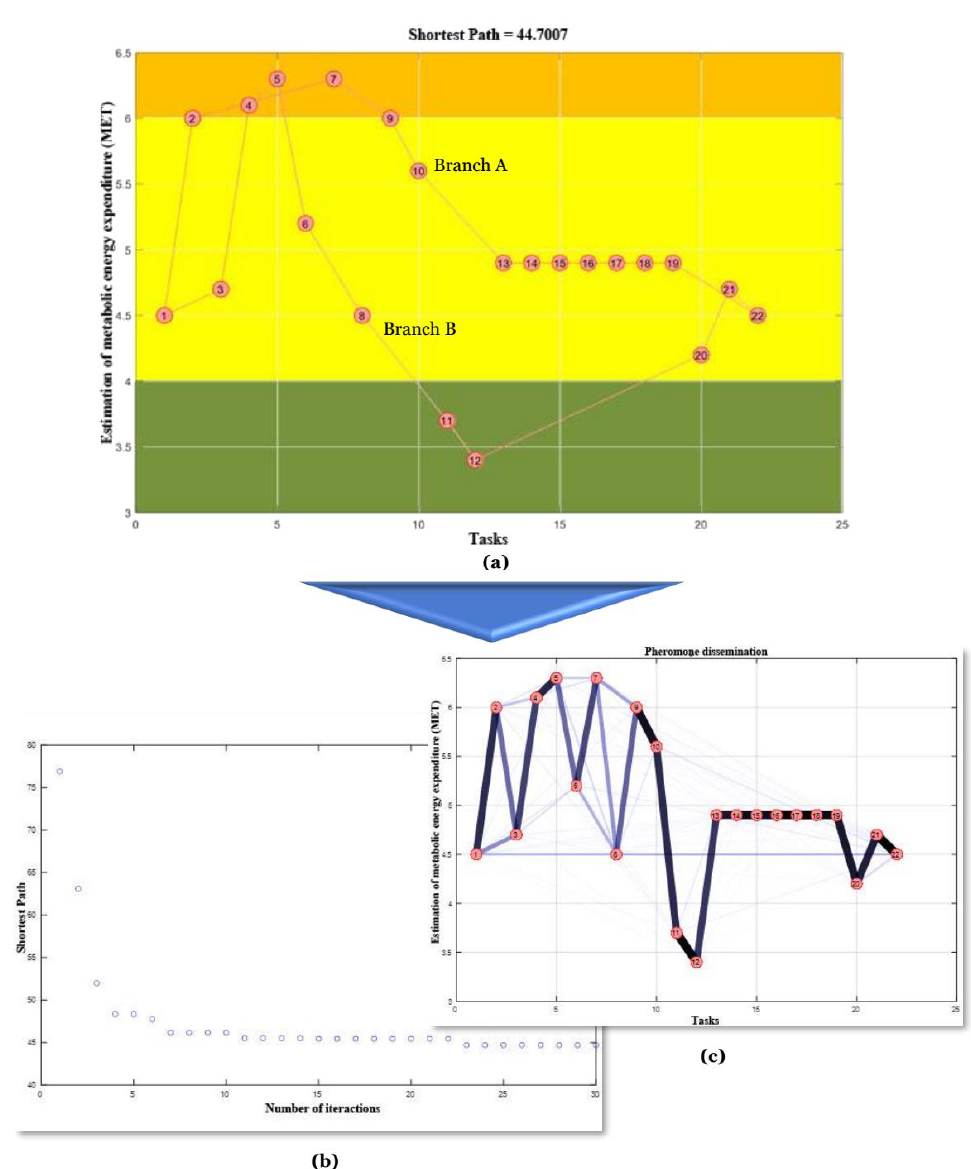
Figure 5. Graph representation of scenario 2. ( a ) Solution for optimizing the planning of production activities for the high season (during the harvest), including Madeira wine, with the various levels of metabolic energy expenditure in METs. ( b ) Evolution of the shortest path minimization process.